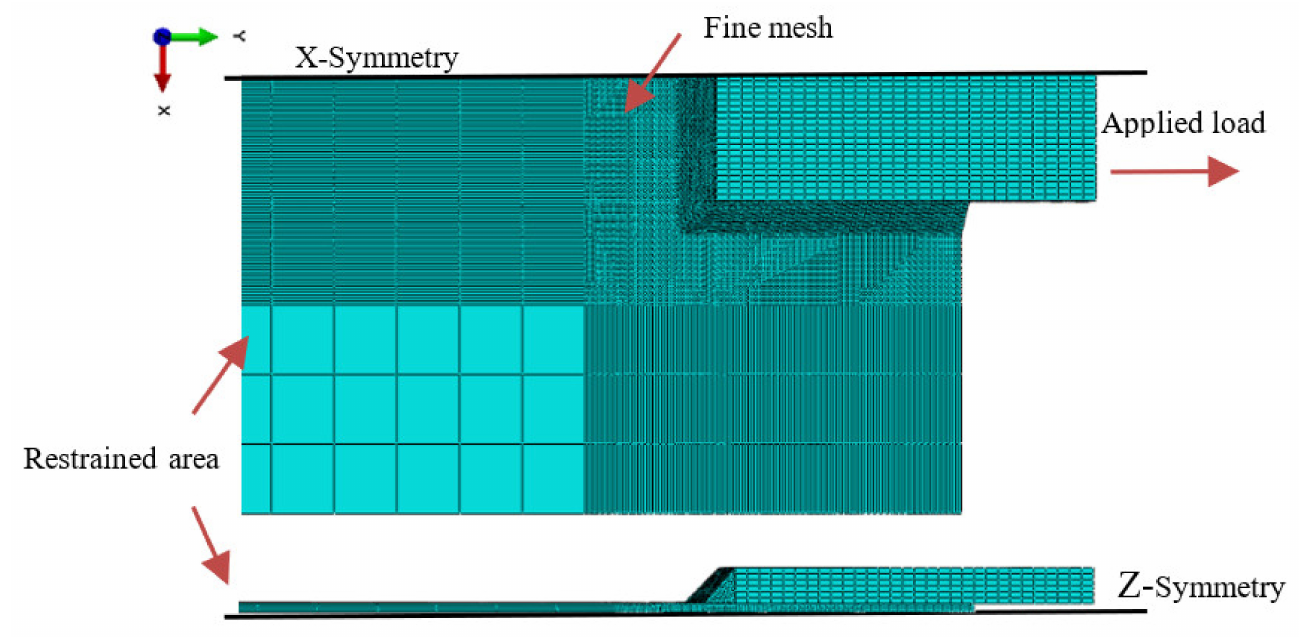
Figure 5. Meshed model and boundary condition.